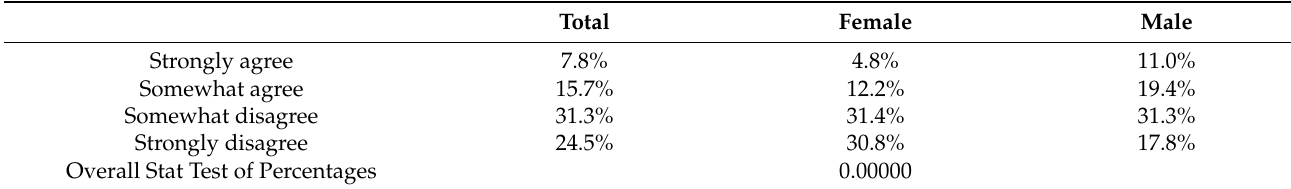
Table 4. I believe lower prices for consumers is more important than drinking Canadian